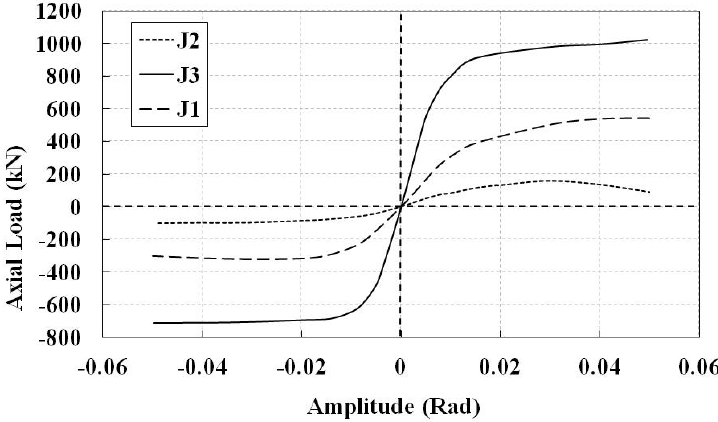
Figure 9. Envelope of the hysteresis diagrams. Non-retrofitted J1, J2, and J3 models including the welding process.